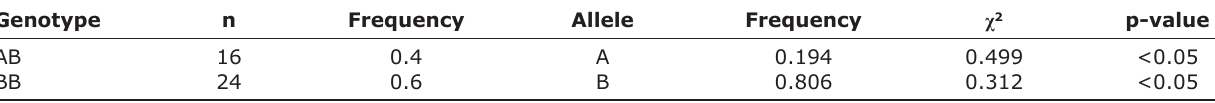
Table-1: Genotypes and allele frequencies of PCR-RFLPs of the Nramp1 gene in pigs.